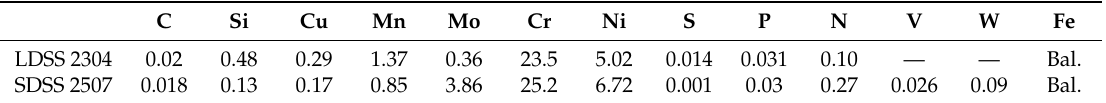
Table 1. Chemical composition of the base metals (wt %): lean duplex stainless steel (LDSS); super duplex stainless steel (SDSS).